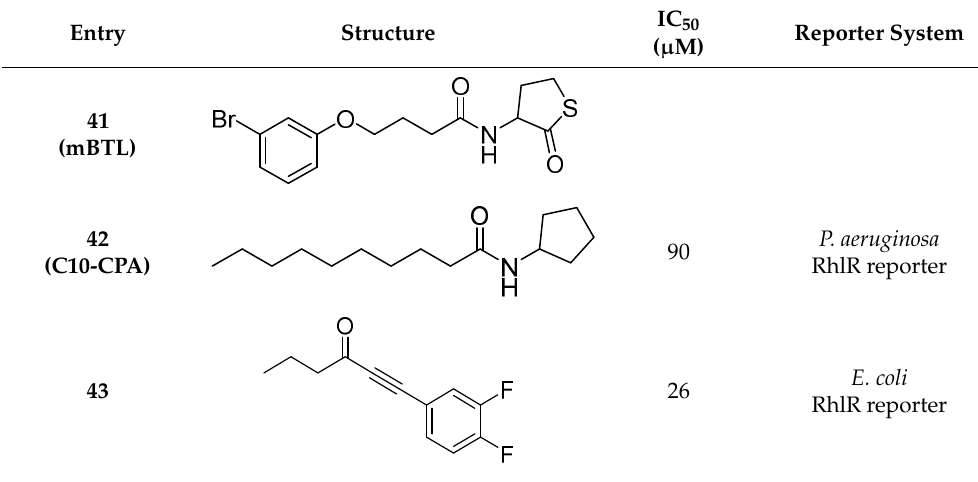
Table 5. Non-BHL RhlR antagonists.